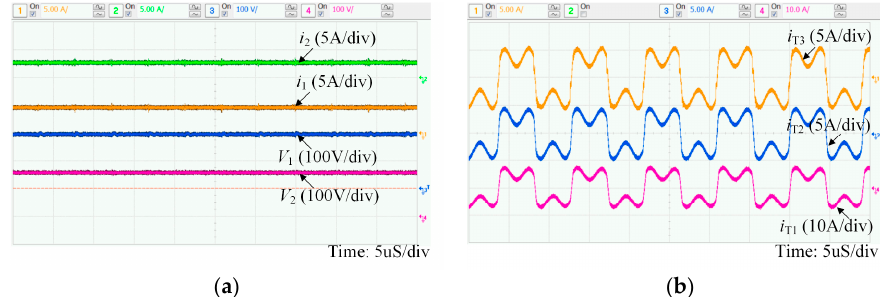
Figure 15. Experimental results of MR-TP-BDC under reverse rated operating mode: ( a ) output voltage and current of port 1 and port 2; ( b ) resonant currents of three ports.